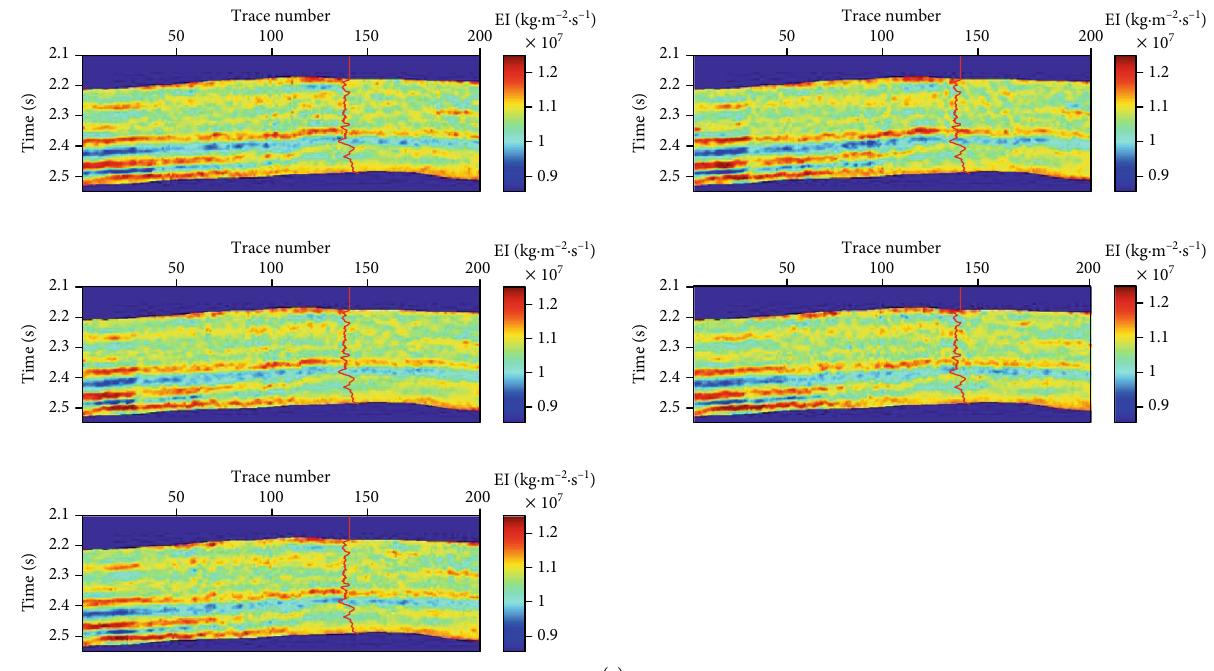
Figure 11: Inverted azimuthally anisotropic EI data with fi ve azimuths, where (a) is the near-angle EI data, (b) is the middle-angle EI data, and (c) is the far-angle EI data. Note that the fi ve azimuths are 20 ° (ranged from 0 ° to 40 ° ), 55 ° (ranged from 35 ° to 75 ° ), 90 ° (ranged from 70 ° to 110 ° ), 125 ° (ranged from 105 ° to 145 ° ), and 160 ° (ranged from 140 ° to 180 ° ), respectively.